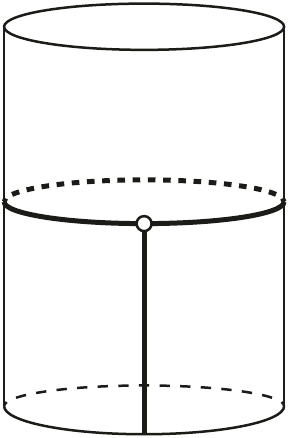
Figure 1 . Graphical interpretation of the L(cid:127)uscher correction is shown. Solid thick line represents the physical particle which arrives from the in(cid:12)nite past and is absorbed by the operator represented by a solid circle. The trajectory of a virtual (mirror) particle is represented by a half solid, half dashed ellipse. The operator emits this virtual particle, which travels around the world and is absorbed by the operator again leading to a 3-particle form